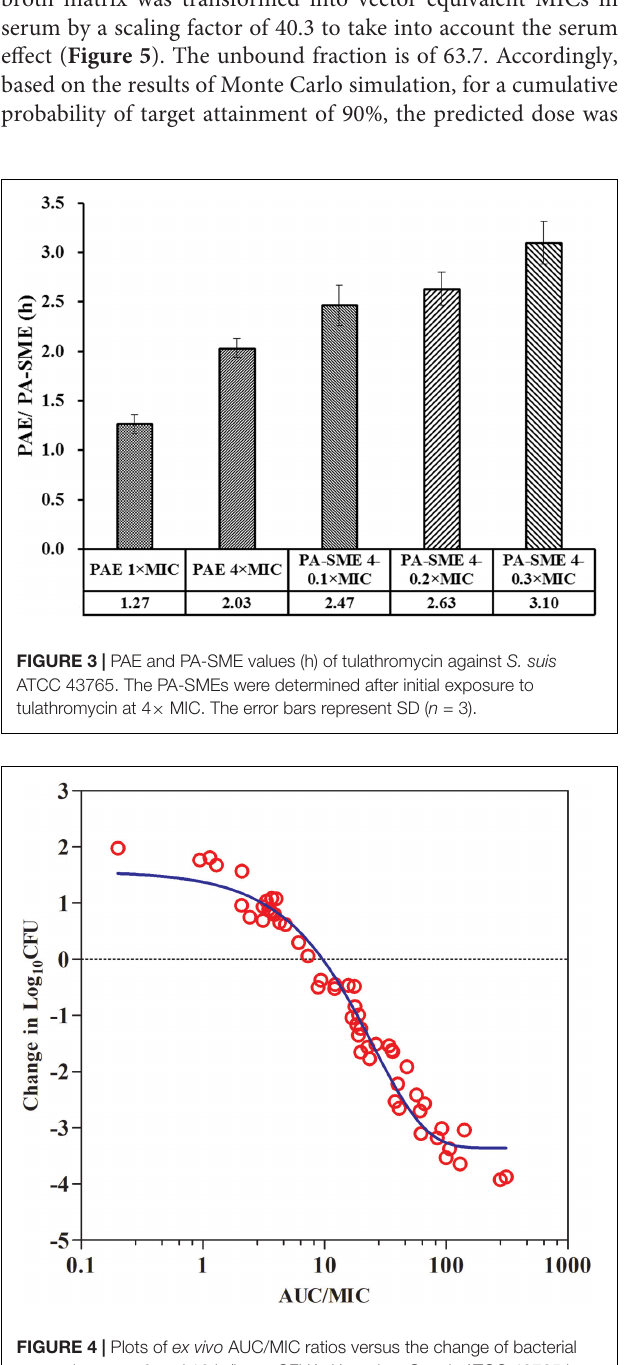
FIGURE 4 | Plots of ex vivo AUC/MIC ratios versus the change of bacterial counts between 0 and 12 h (log 10 CFU/mL) against S. suis ATCC 43765 in the porcine serum. The line represents the curve of predicted values based on the sigmoid E max equation, and the points represent serum samples collected at time points from 0 to 360